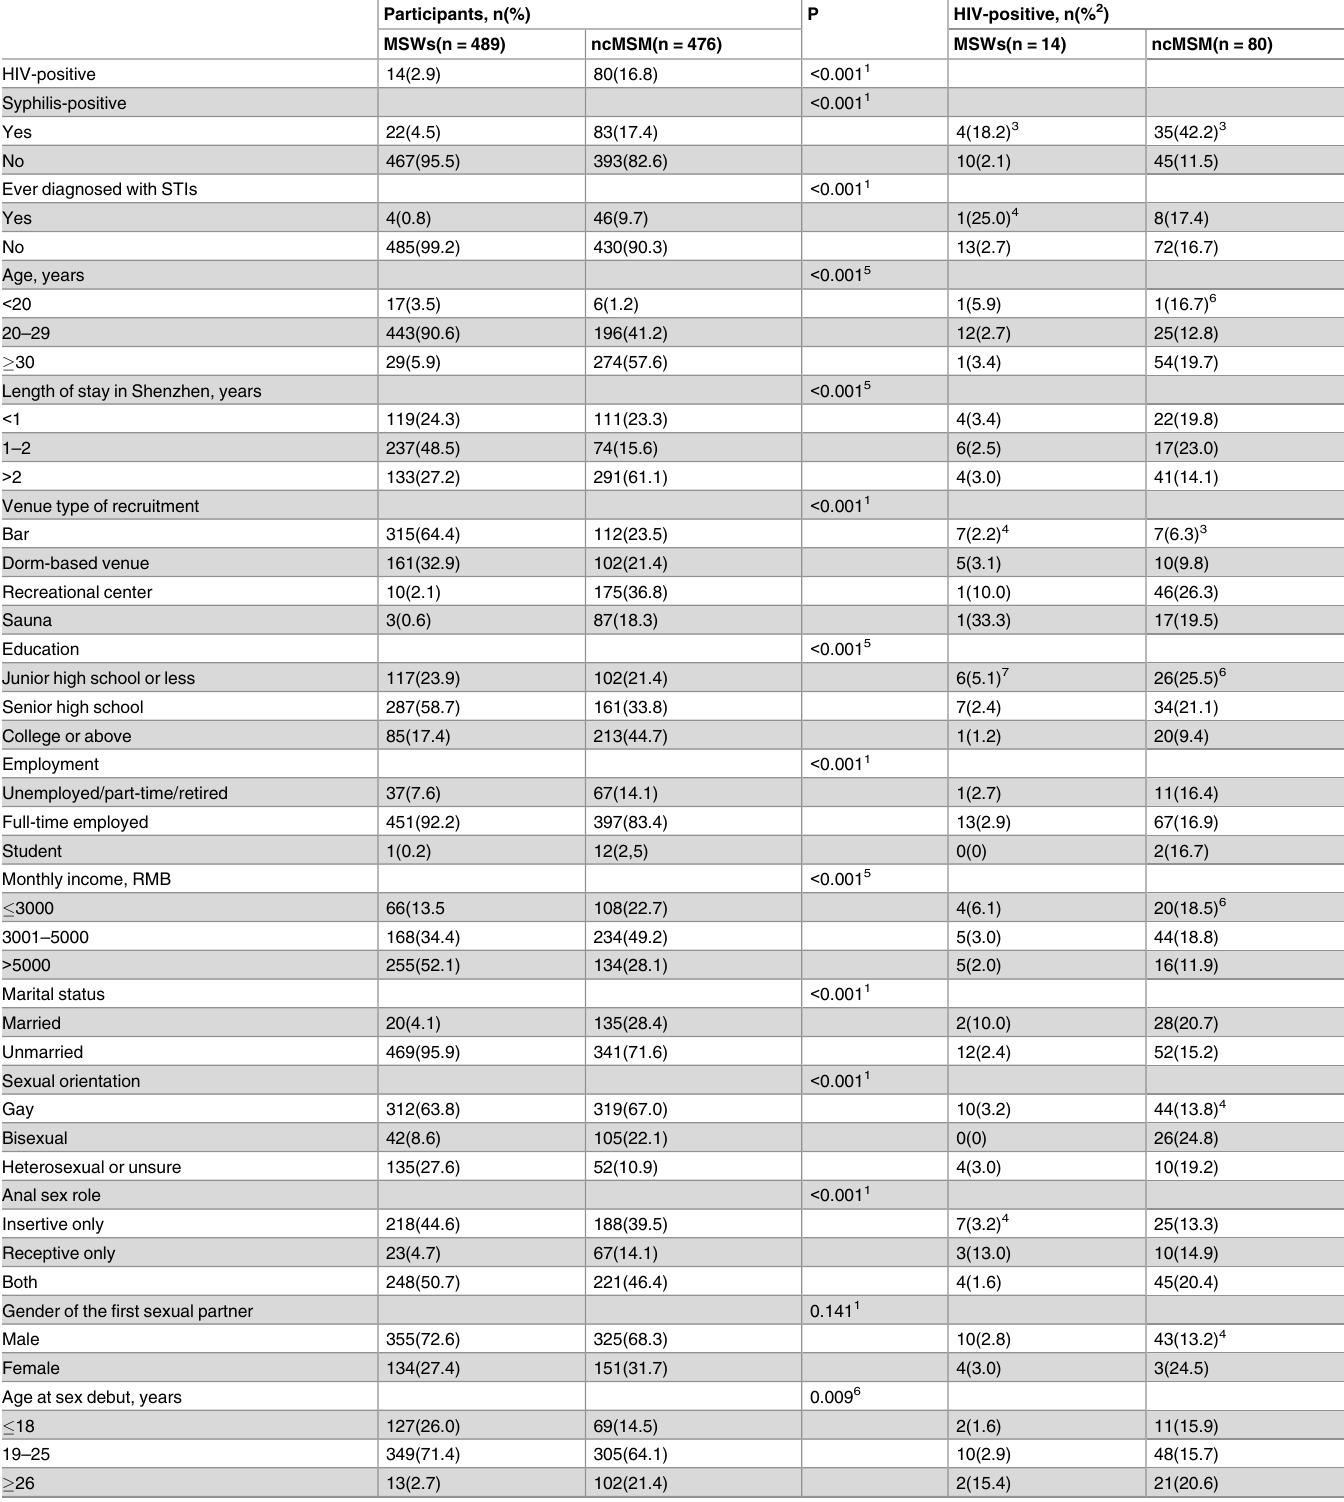
Table 1. HIV infection and demographic/sexual behavior characteristics in MSWs and